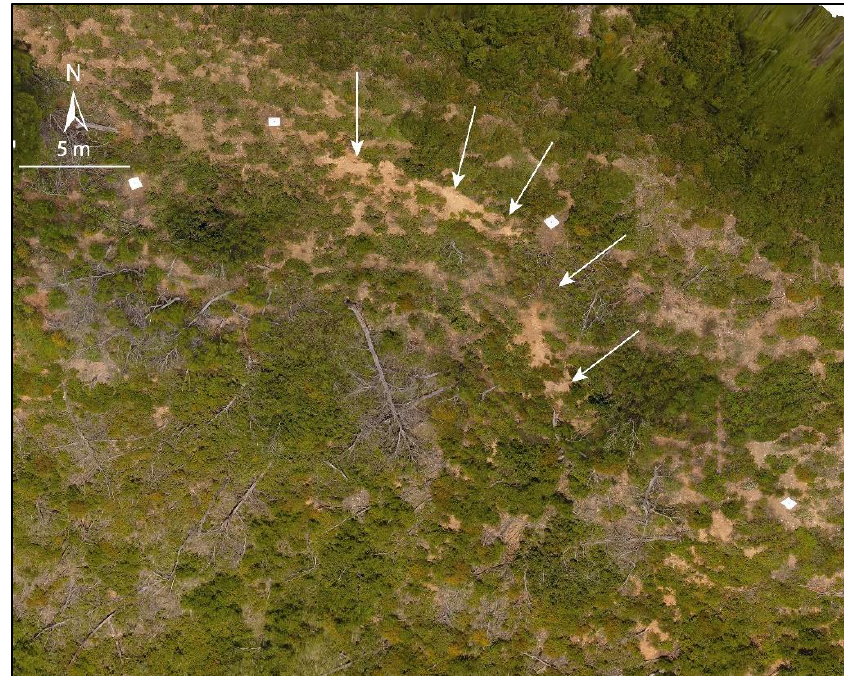
Figure 12. Orthomosaic of the Agios Stefanos study area. The entire slope was covered by new vegetation after the 2012 wildfire, while burned trees were still lying in the ground. The black arrows show the existing landslide scarp. Four 50 cm × 50 cm aluminium rectangles were used as GCPs and are visible in white colour.